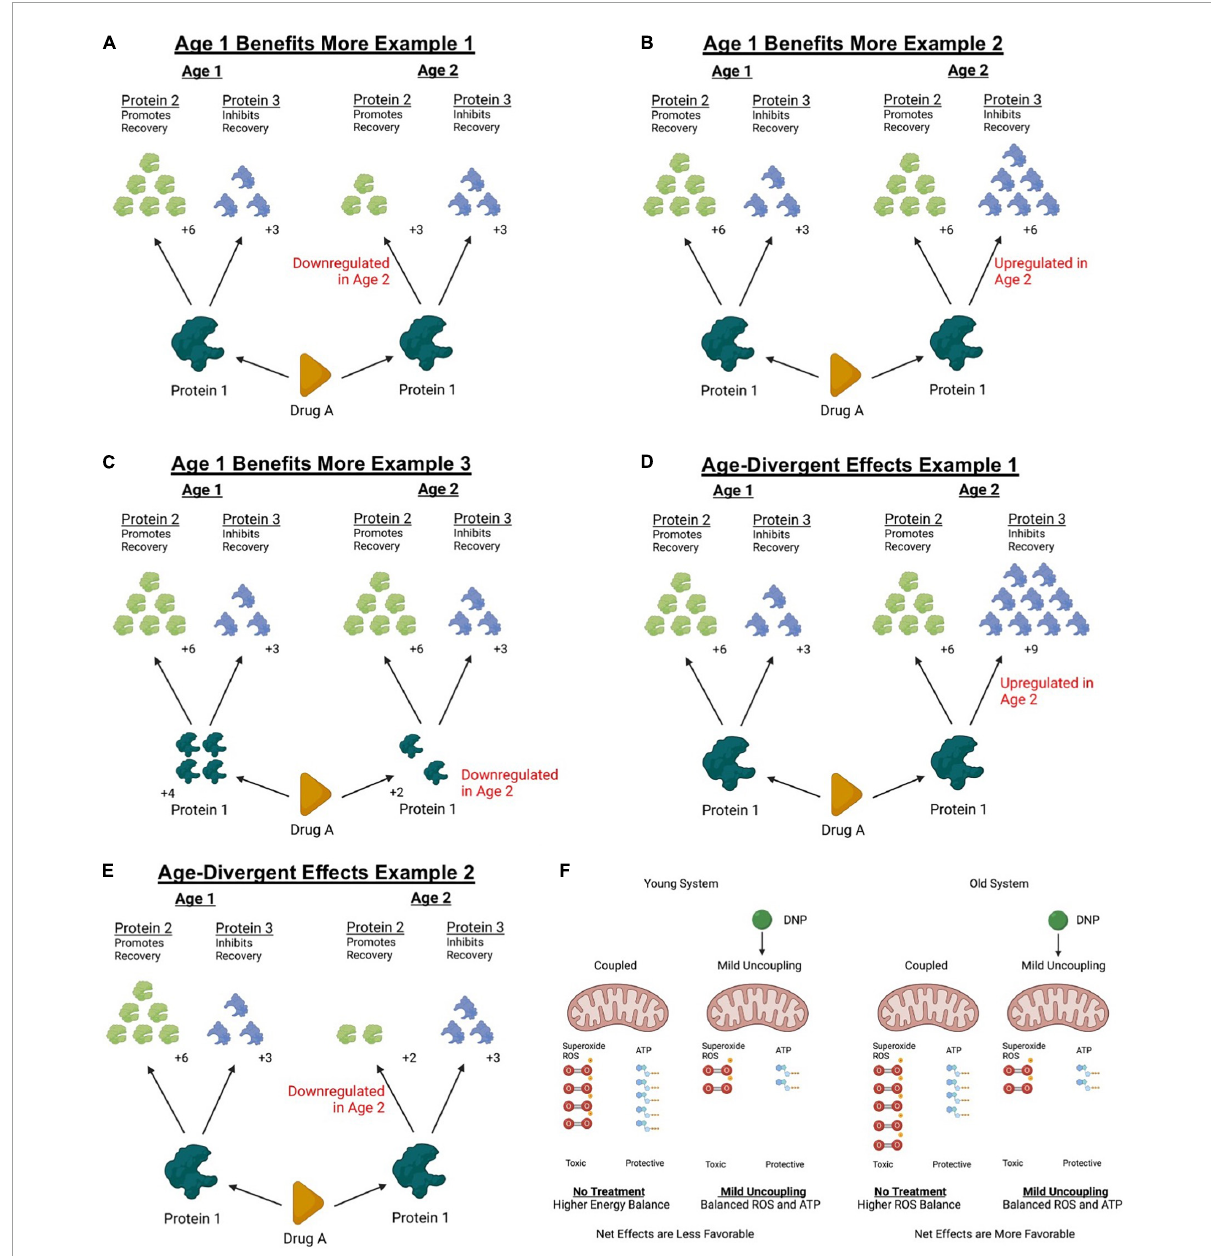
FIGURE1 Theoretical models of how age can affect response to treatment. Treatments targeting molecular mechanisms often exert downstream influence on several biological targets. Downstream effectors of a therapeutic intervention can exert both permissive and detrimental effects that can compete to determine the net outcome of a treatment. Aging can change protein abundances of diverse molecular pathways as well as affect cellular responses to injury. Panels (A–F) represent some simplified theoretical models of how changes occurring with age can affect net responses to treatment. (A) For example, if a reparative downstream effector of an interventions biological target is downregulated with age, older systems might not respond with as large of a therapeutic response. (B) Similarly, if a detrimental effector of the intervention is upregulated with age, the net effects might appear smaller in an older animal or disappear altogether. (C) Further, the abundance of the biological target itself could be differentially regulated with age and affect treatment efficacy. (D) It could also be possible for the net balance of a treatment to change from a beneficial effect to a toxic effect if detrimental downstream regulators are upregulated beyond the effectors that might confer a treatment benefit. (E) Or finally, the abundance of the beneficial biological target could be downregulated with age to a point where